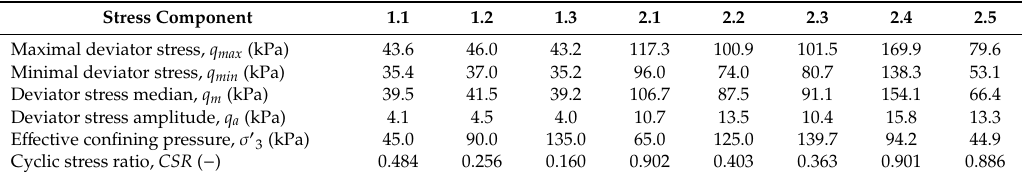
Table 3. The cyclic triaxial test